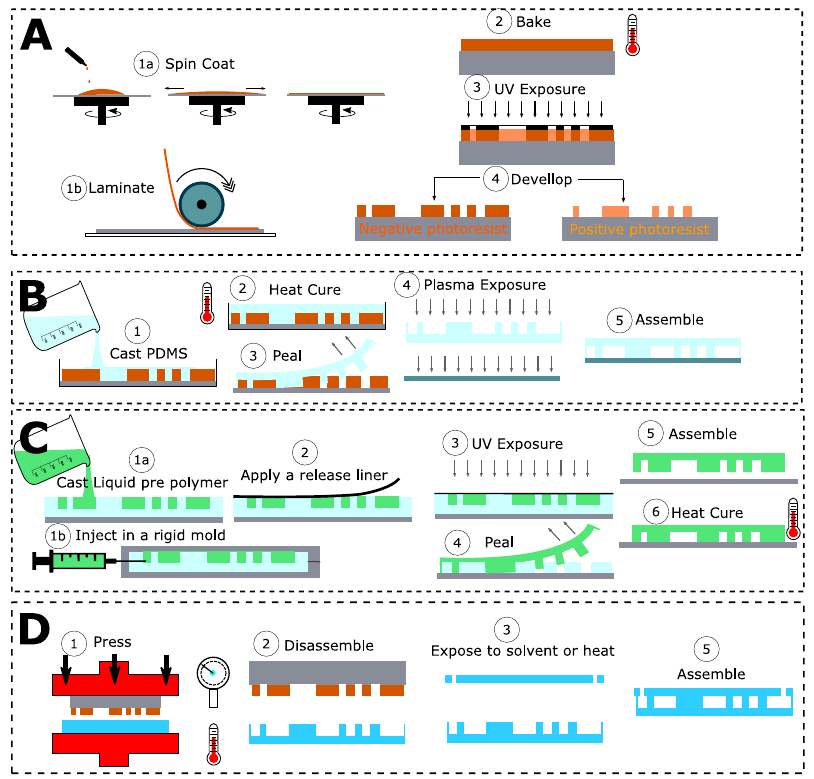
Figure 3. Overview of the most widely used techniques for master-mold and microfluidic chip fabrication. ( A ) Mold fabrication technique using liquid photoresist (1a) or dry film photoresist (1b). ( B ) Microfluidic chip fabrication using polydimethylsiloxane (PDMS). ( C ) Microfluidic chip fabrication using dual cure liquid-prepolymer (Epoxy, OSTEMER, NOA, thiolene, etc.) by cast molding technique (1a) or reactive injection molding (1b). ( D ) Microfluidic chip fabrication using thermoset polymers by hot embossing.